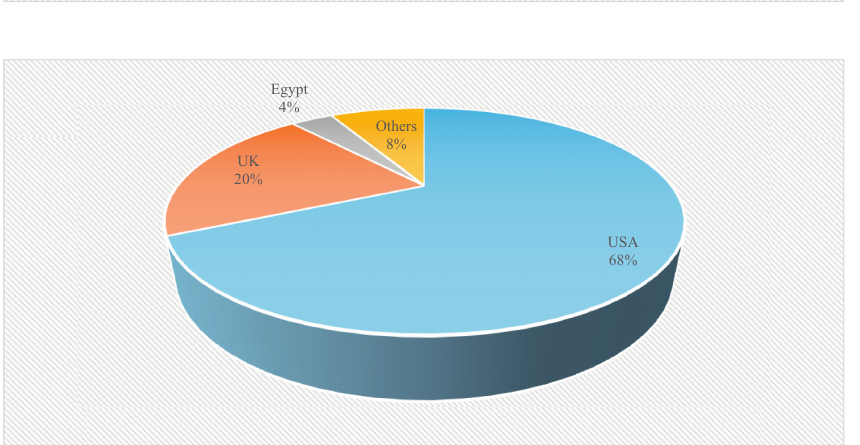
Figure 2. The percent of the covered STEM e- courses